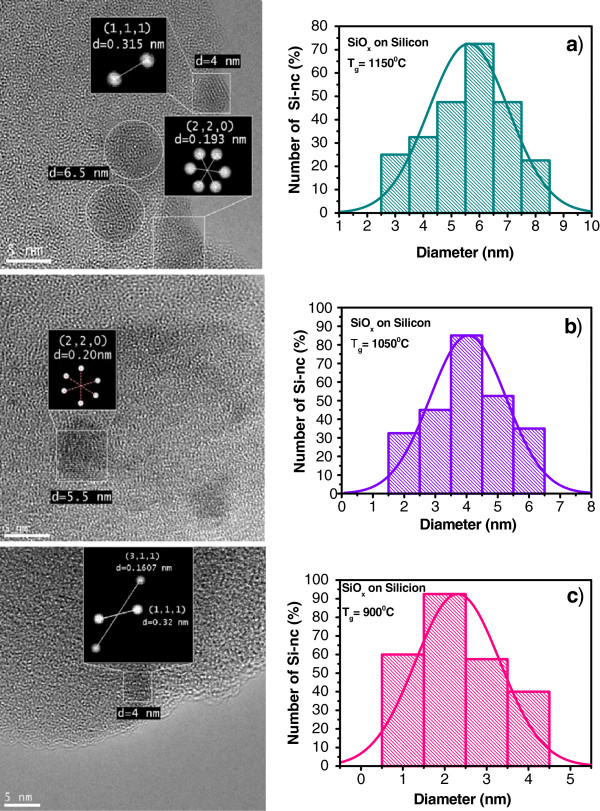
The plain-view HRTEM images and histograms of the SiOxfilms. For samples with Tg at (a) 1,150°C, (b) 1,050°C, and (c) 900°C.